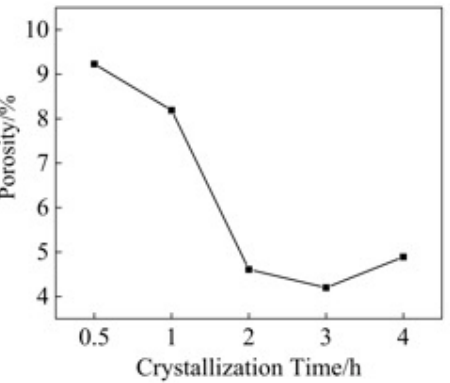
Figure 14. Effect of crystallization time on the porosity of the microcrystalline